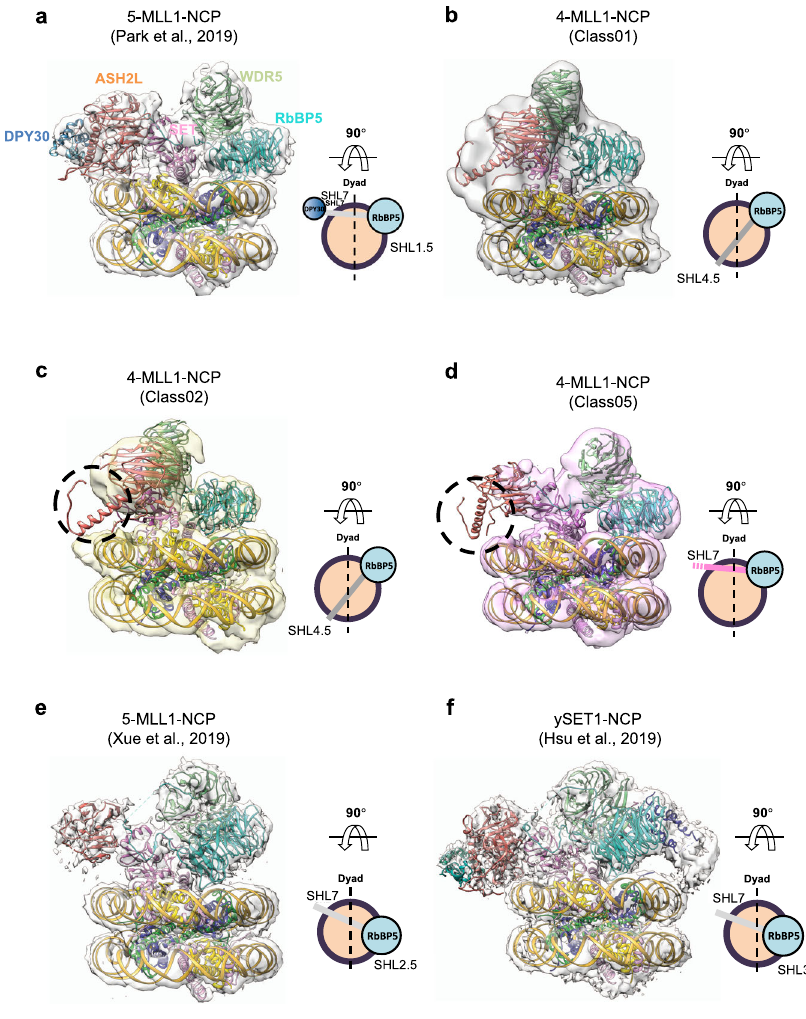
Fig. 5 Cryo-EM structure of the 4-MLL1-NCP complexes. a Front views of the MLL1 RWSAD -NCP (PDB ID: 6PWV [https://doi.org/10.2210/pdb6pwv/pdb] and EMDB: EMD-20512) 37 . The 90 ° top view, on right, shows the relative position of the anchoring points. DNA, yellow; DPY30, blue; ASH2L, orange; WDR5, light green; RbBP5, cyan. The NCP (histone octamer core, orange circle; DNA, black), RbBP5 (cyan circle), and DPY30 (blue circle), and the remaining MLL components were displayed as a gray bar indicating the orientation of the MLL1 complex. b – d Front view of the 4-MLL1-NCP structures. The 90 ° top view shows its anchoring points on the NCP. The missing EM density of ASH2L IDRs and DPY30 were indicated as black dash-circle in ( c – d ) and as a dashed line end in the accompanying cartoons. e – f Alternative conformation for the human 5-MLL1-NCP structure 38 and ySET1-NCP 46 as well as their respective top view. ASH2L/Bre2 in both structures interact with the NCP near SHL 7 with slight rotational dynamics at the RbBP5/Swd1-NCP contact